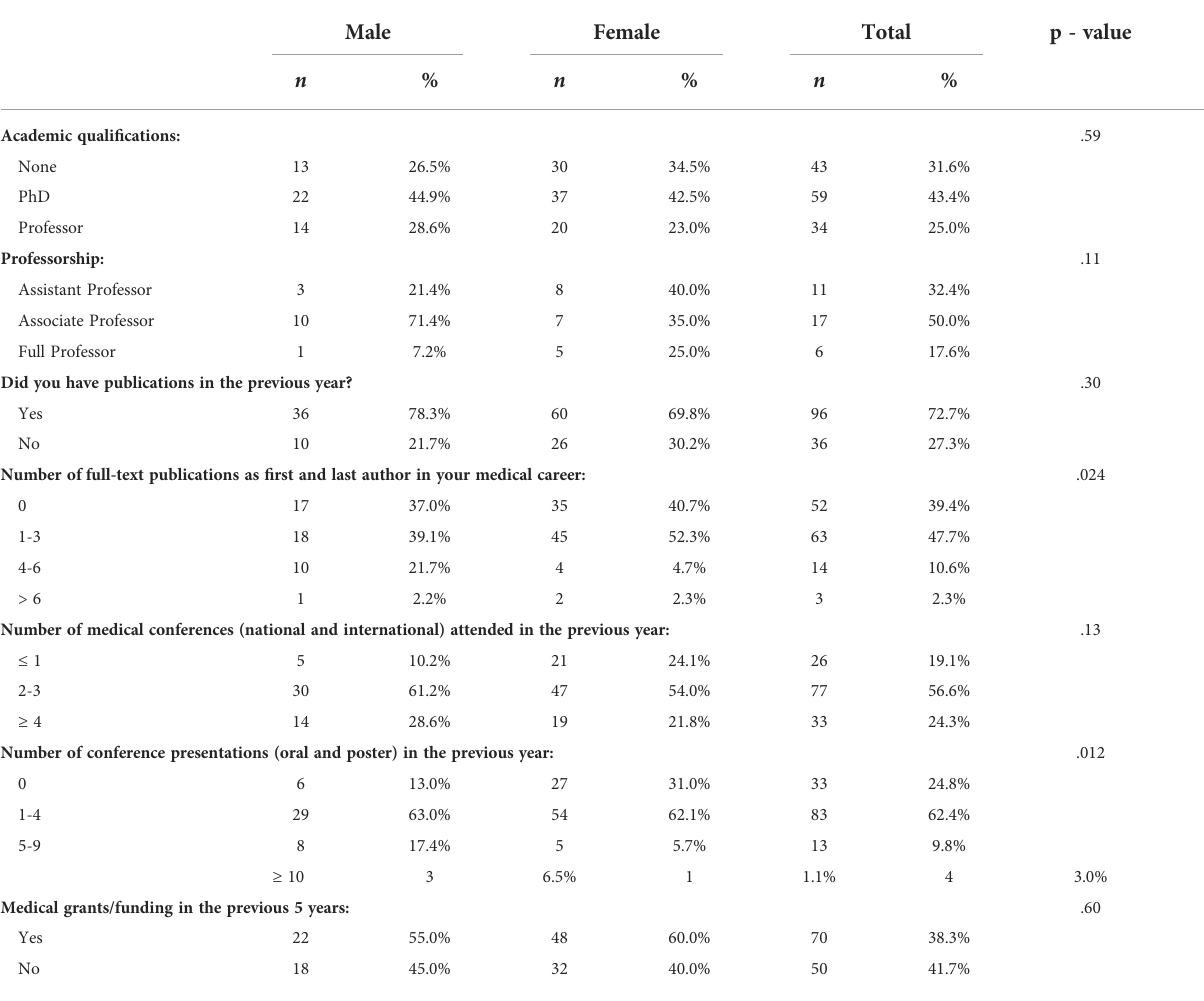
TABLE 4 Academic